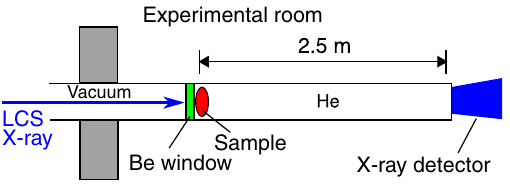
FIG. 28. LCS x-ray flux during image